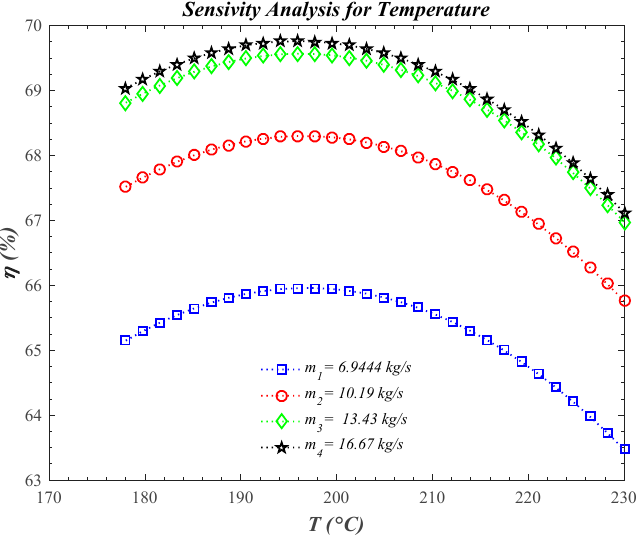
Figure 17. Temperature sensitivity analysis at four different flow rates.